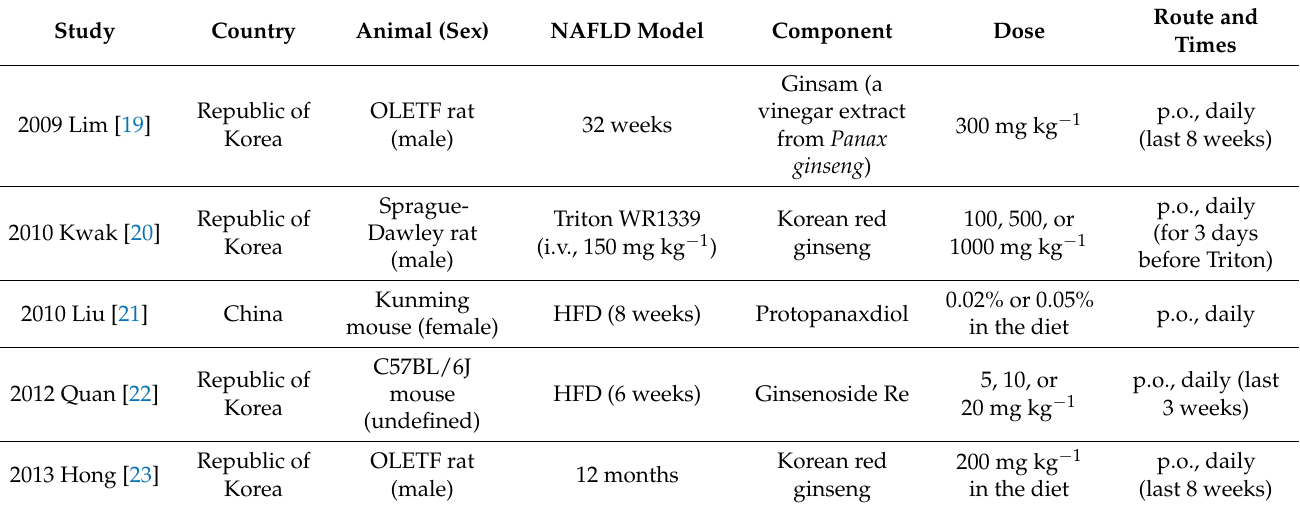
Table 2. Overall characteristics of included literature.